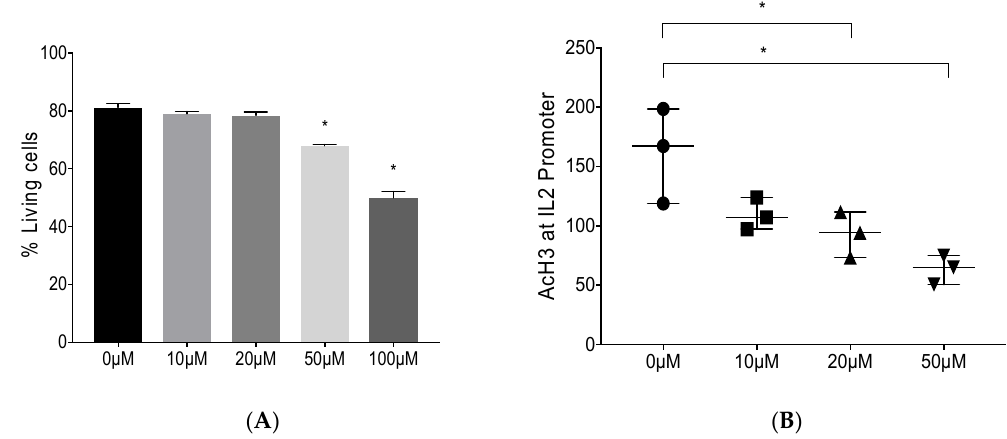
Figure 1. Epigenetic modulation by anacardic acid (AA) promotes histone de-acetylation. Feline Mya-1 cells, a CD4 + T cell line, were treated with anacardic acid (AA) at 0, 10, 20, 50, and 100 μM for 24 h. ( A ) Cell viability was measured by flow cytometry as described in the methods using DAPI as the live-dead stain. Data are represented as the mean+ SD, n = 3 ( B ). Acetylated Histone 3 (AcH3) chromatin immunoprecipitation (ChIP), followed by qPCR demonstrated a reduction in histone acetylation at the interleukin-2 (IL-2) promoter. Data are represented as the median with range, n = 3. Statistical differences were determined by paired t -test in ( A ) and Wilcoxon matched-pairs signed rank test in ( B ), with * representing p < 0.05.